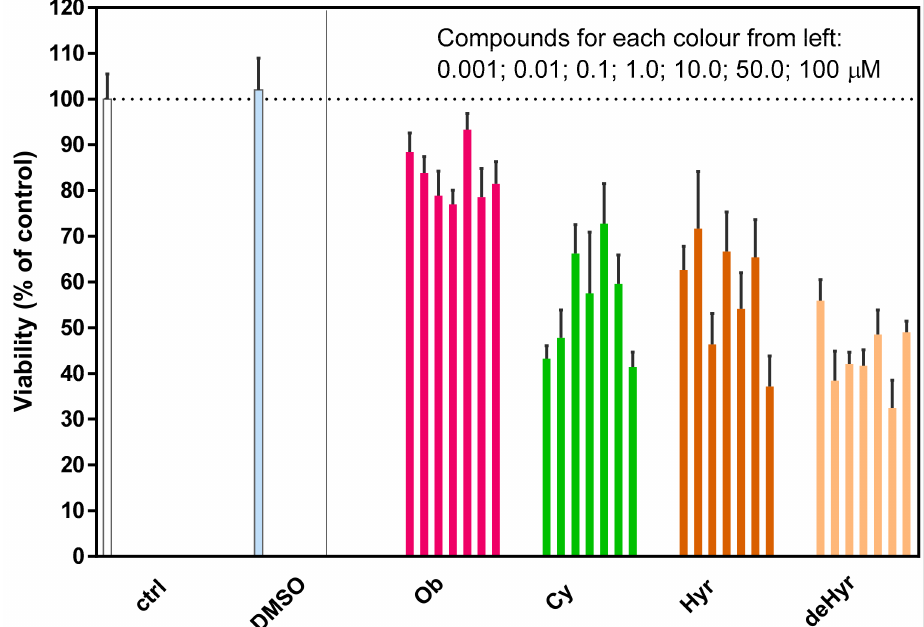
Figure 5. Viability of mouse peritoneal cells. Isolated cells were cultured for 24 h. Individual compounds, i.e., ouabain (Ob), cymarin (Cy), hyrcanoside (Hyr), and deglucohyrcanoside (deHyr), were applied at concentrations of 0.001, 0.01, 0.1, 1.0, 10.0, 50.0, and 100 µ M. The effect of DMSO was also analyzed; its concentration corresponded to 50 µ M concentration of compounds. WST-1 assay was used for viability evaluation. The results are expressed as the percent of untreated controls (ctrl) ± SEM (standard error of the mean) of n = 8 values from two independent